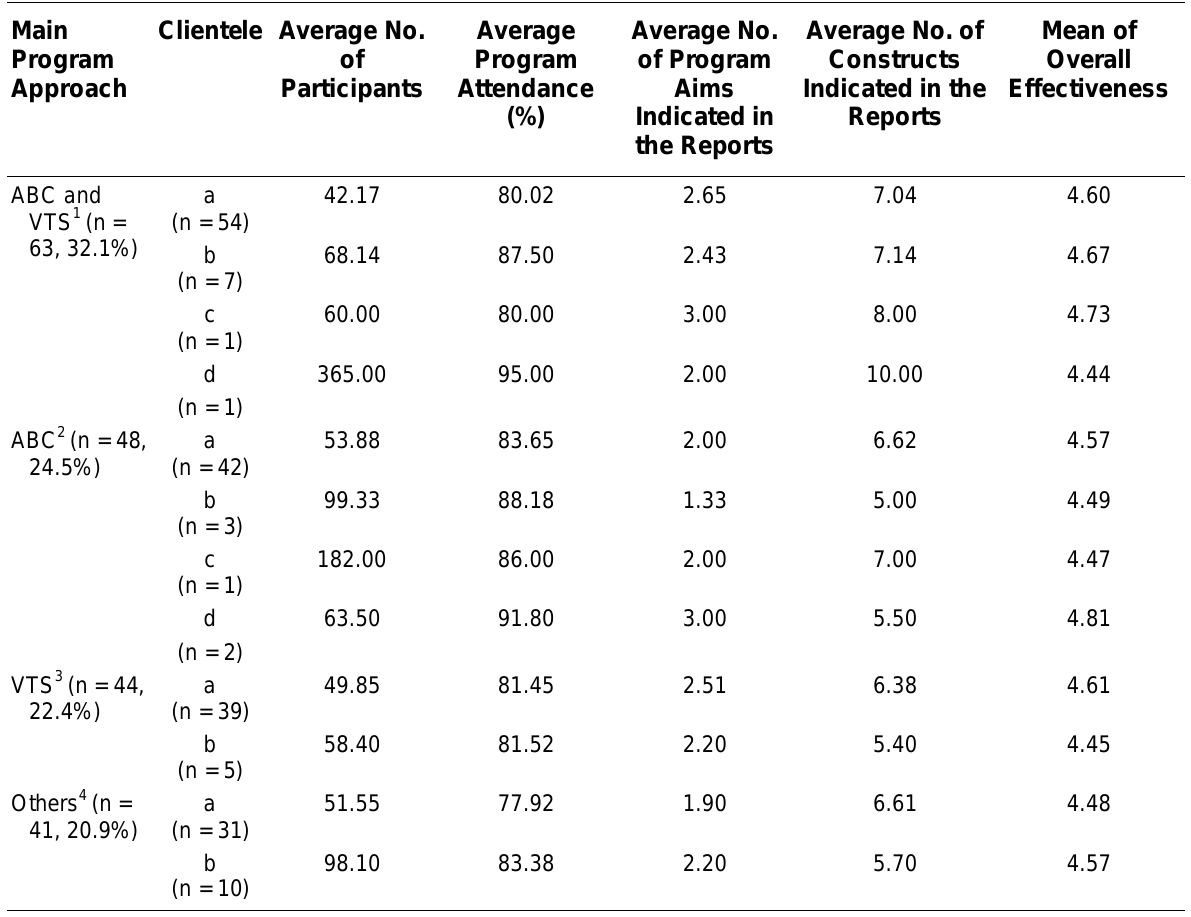
Summary of Program Characteristics and